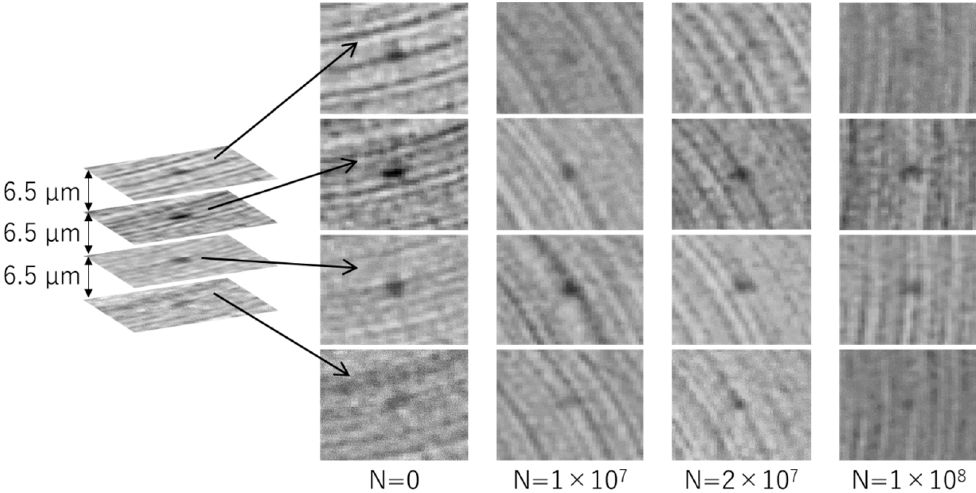
Figure 8. Reconstructed images of an inclusion #21 at every observation step.